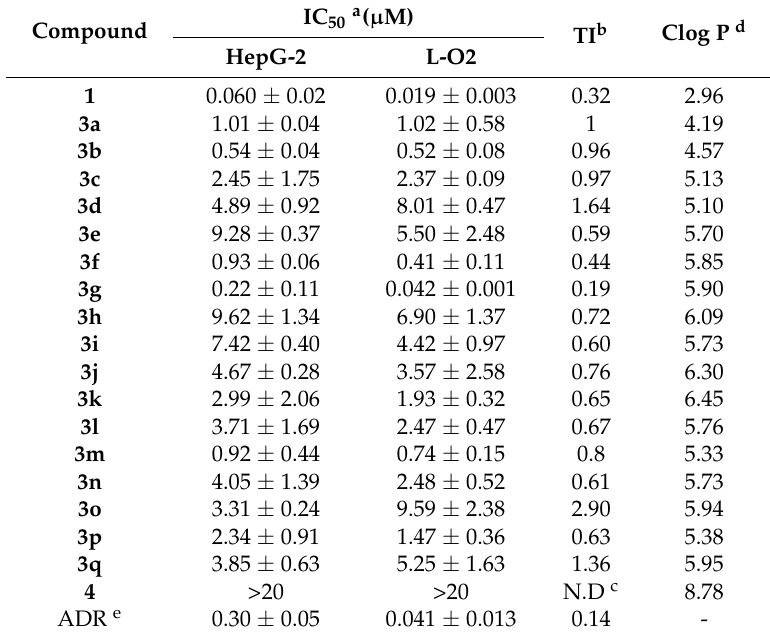
Table 1. The inhibitory activity and clog P of 3a – 3q and 4 against the HepG-2 and L-O2 cell lines.